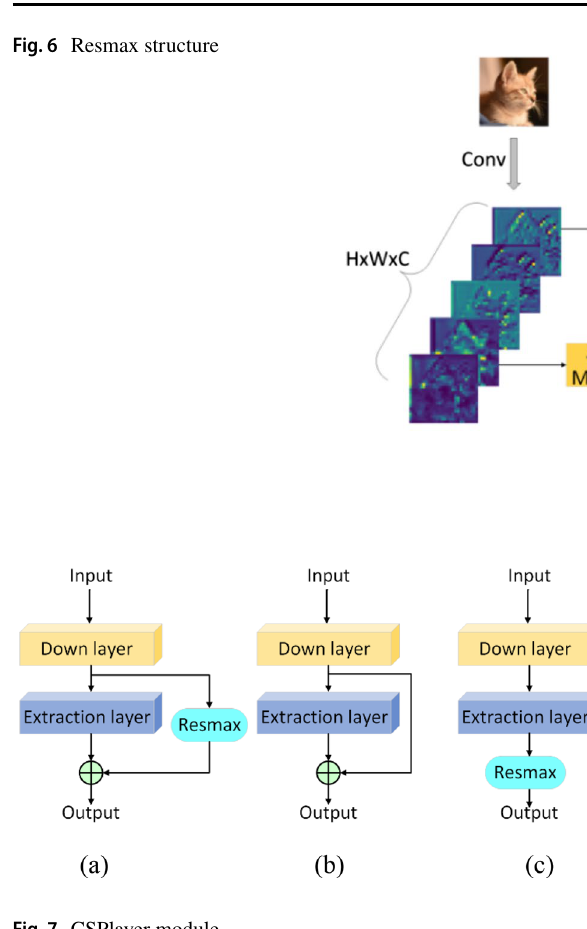
Fig. 7 CSPlayer module